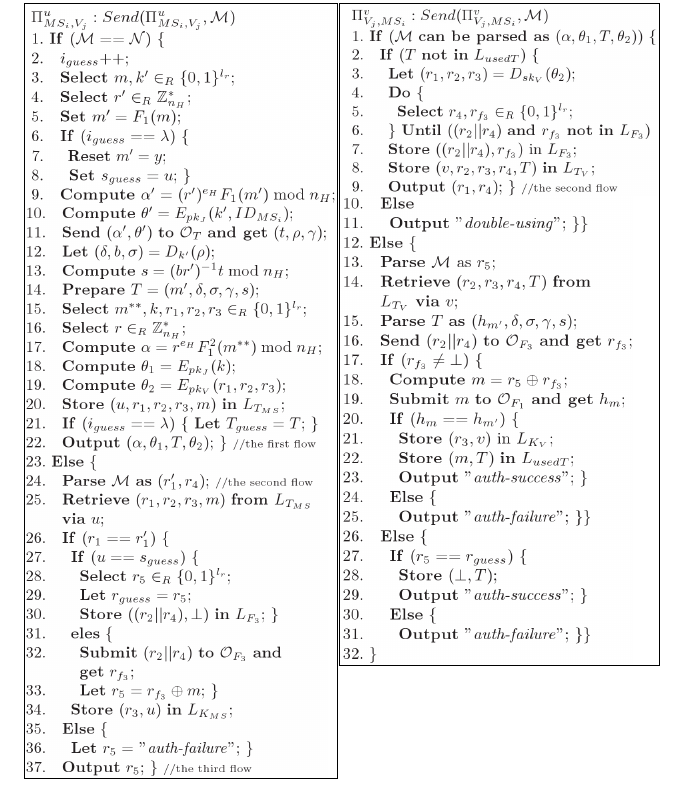
Figure 11. The oracle Π u in the proof of Ticket Swindling MS i , V j